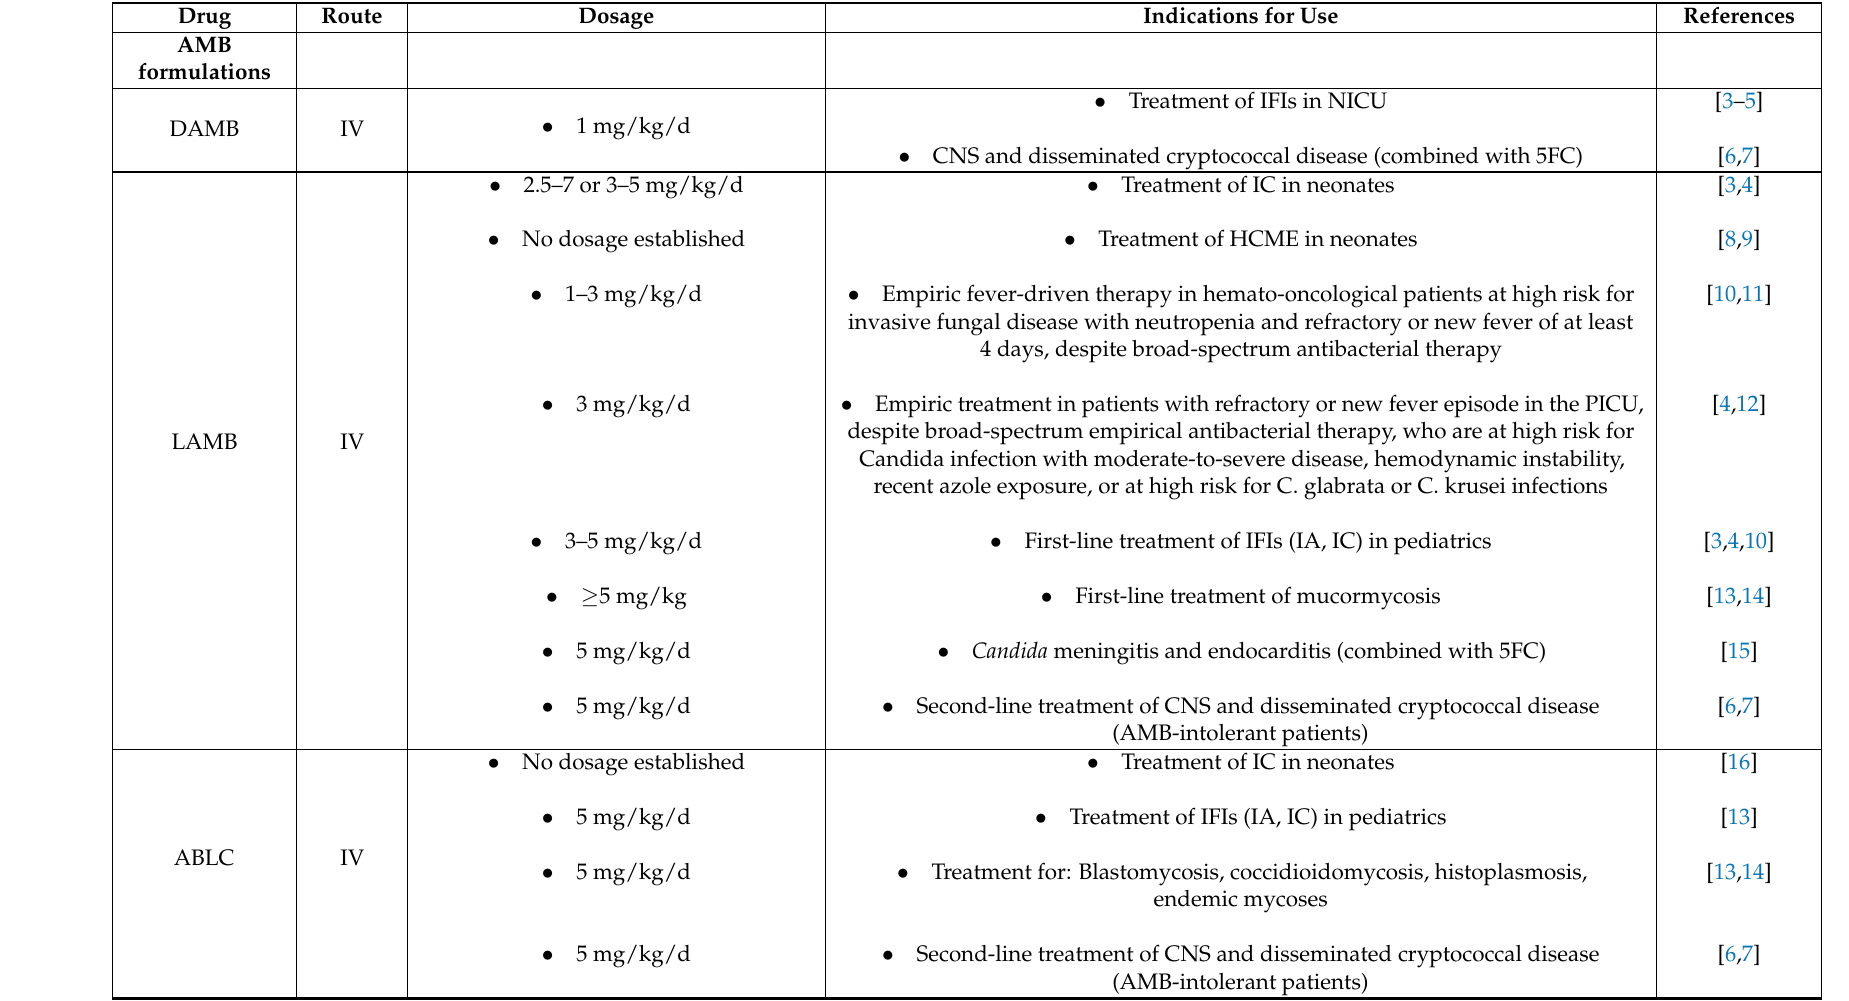
Table 1. Antifungal drugs in pediatric